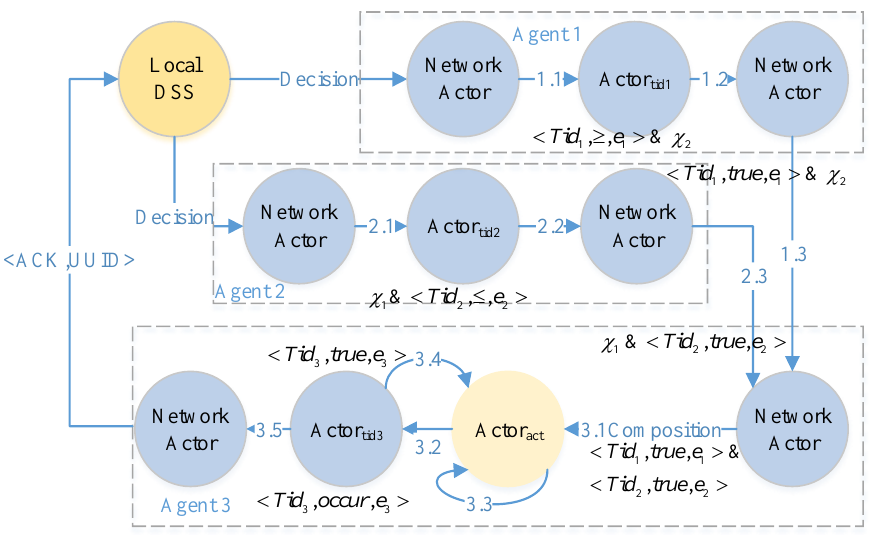
Figure 10. A possible solution for decentralized decision process based on our framework.